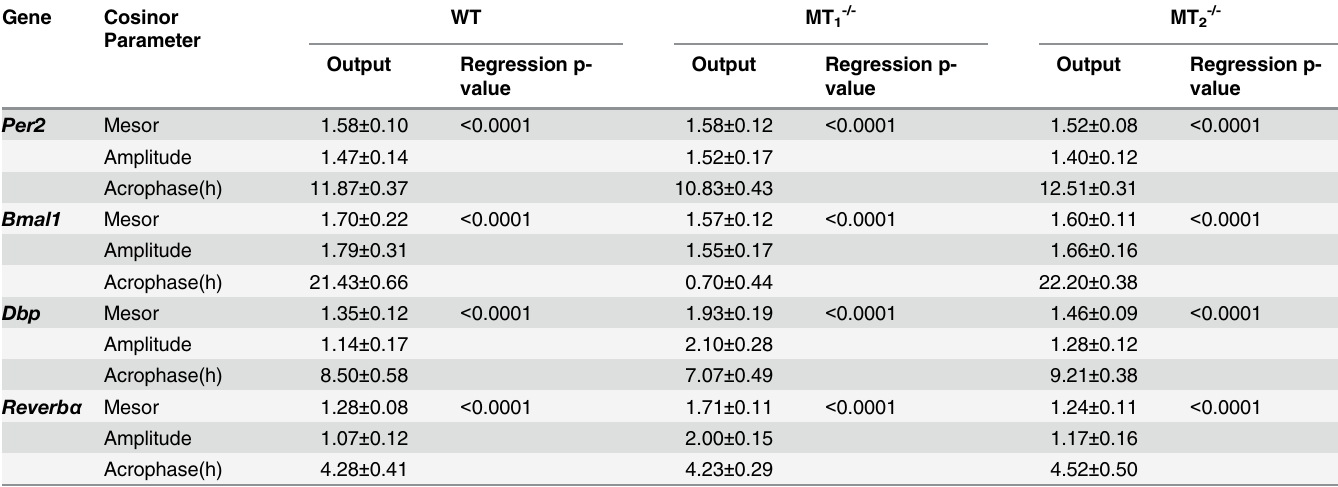
Table 3. COSINOR analysis of clock controlled genes within skeletal muscle of WT, MT1 -/- amd MT2 -/- mice. Gene